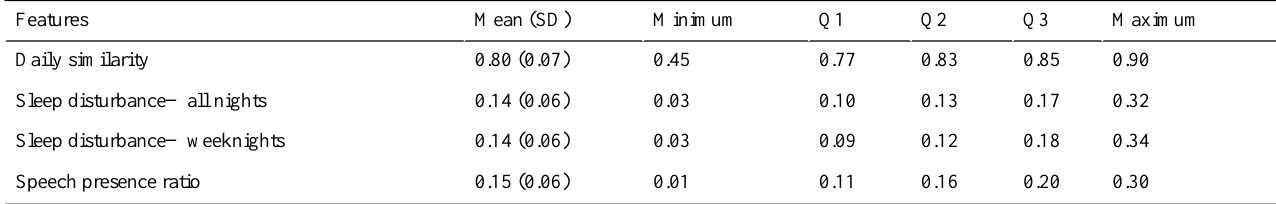
Table 3. Descriptive statistics for objective audio features